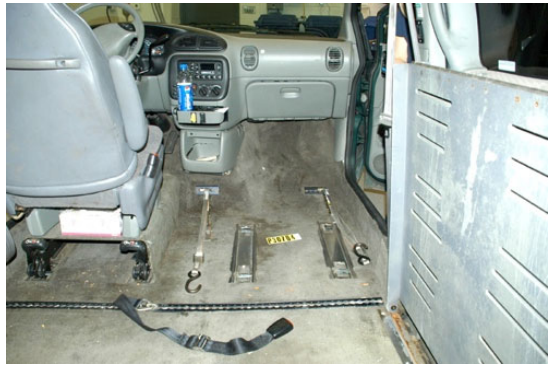
Figure 7. Passenger belt